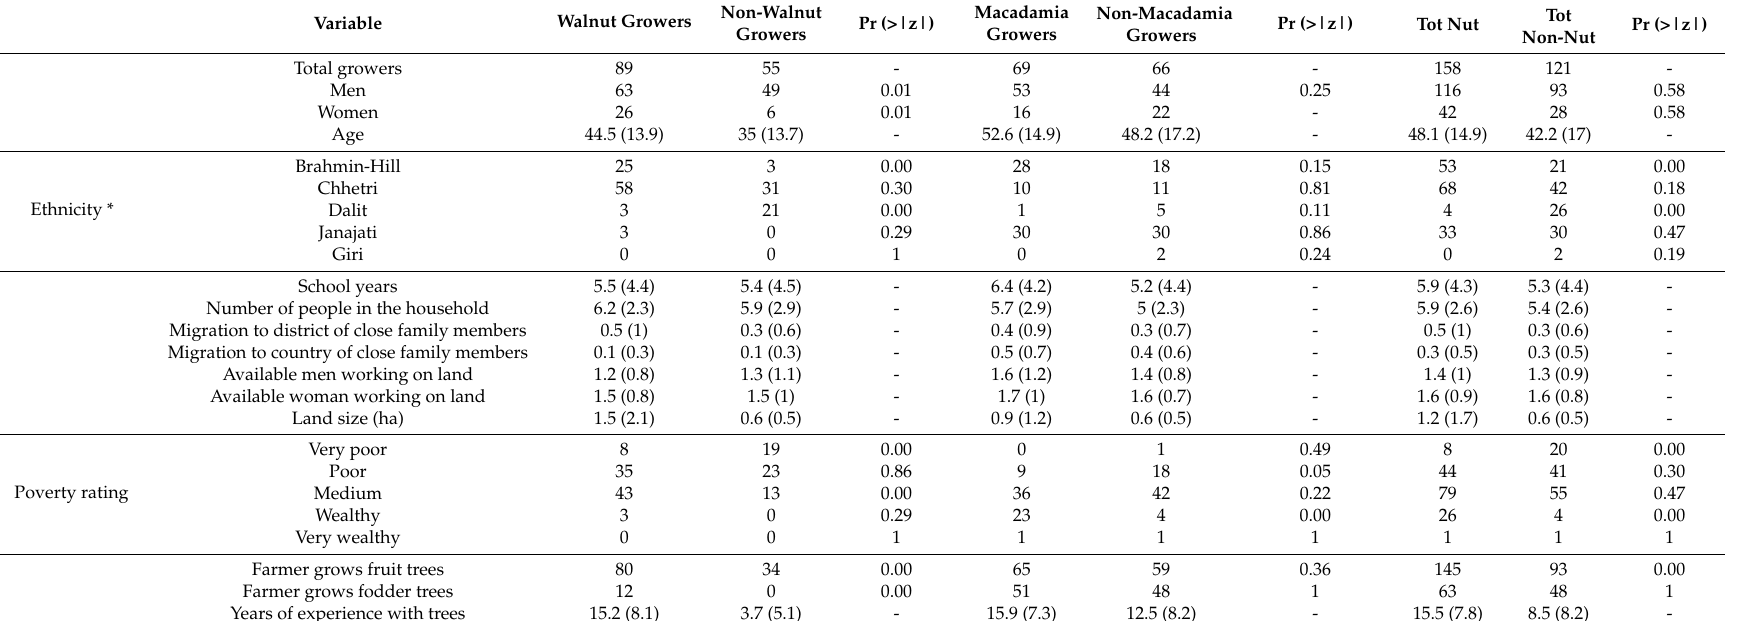
Table 1. Characteristics of households (standard deviation in